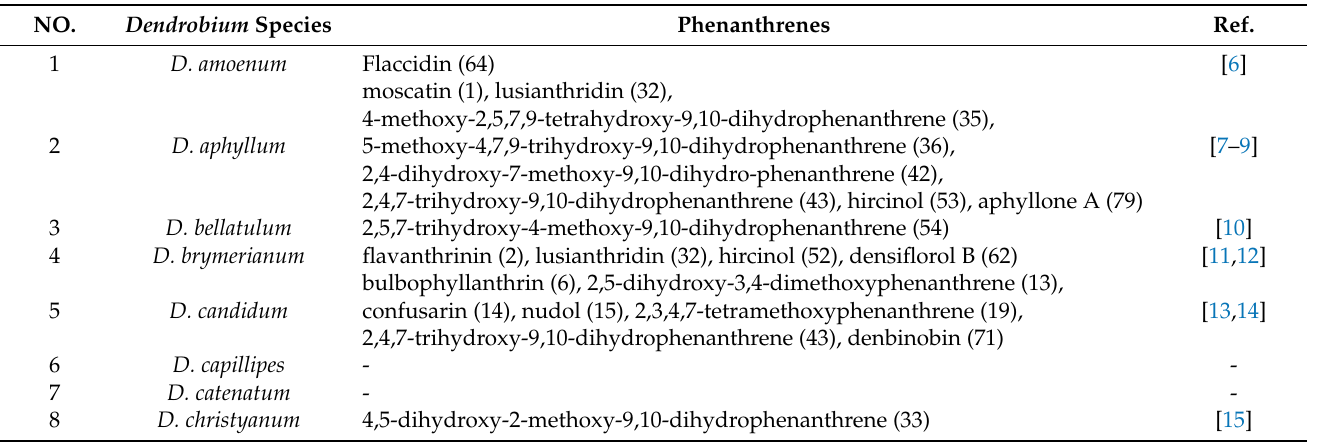
Table 1. Phenanthrenes isolated in Dendrobium species.